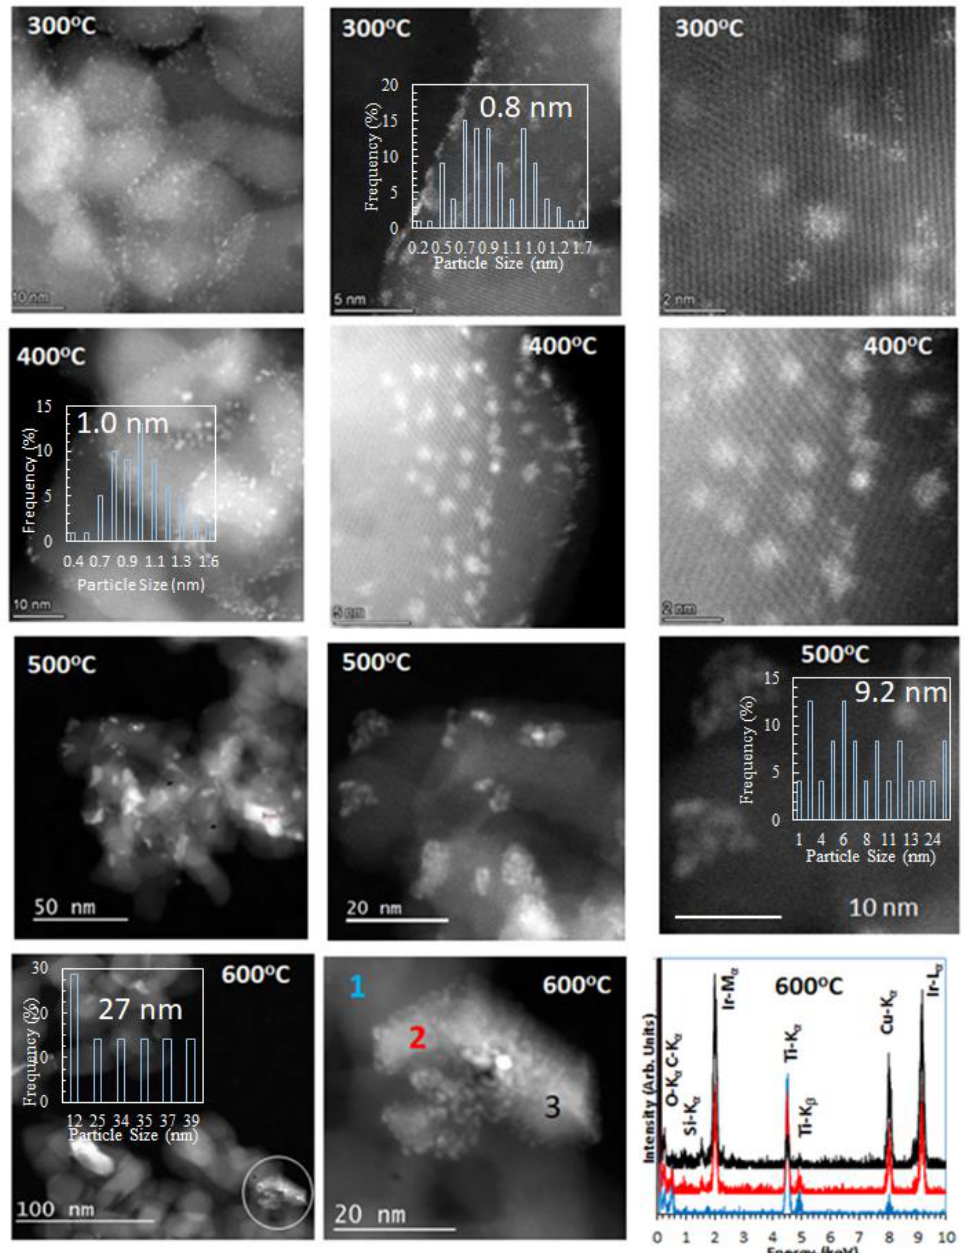
Figure 7. STEM images of 4 wt.% IrO 2 /TiO 2 at different magnifications for samples calcined between 300 and 600 °C for four hours each. Clustering became dominant at 500 °C. The mean particle size is given in the insets. It increased from 0.8 nm upon calcination at 300 °C to 27 nm when the calcination temperature was raised to 600 °C.